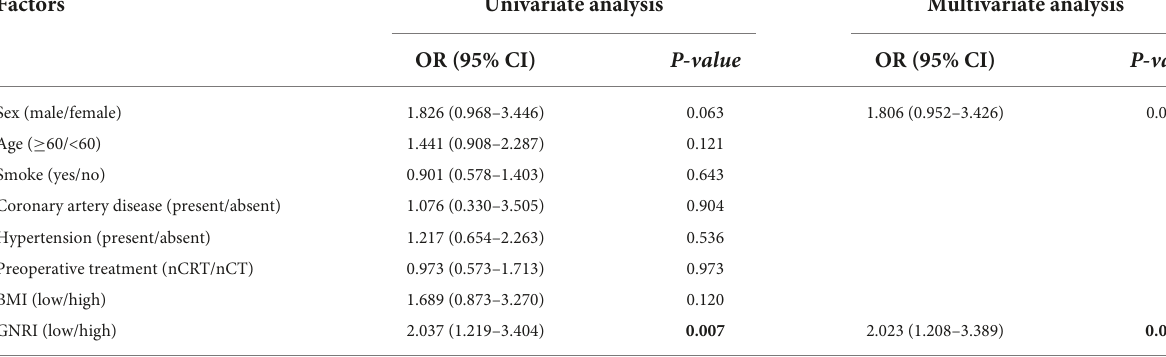
TABLE 3 Logistic regression analysis for clinical factors associated with complications after